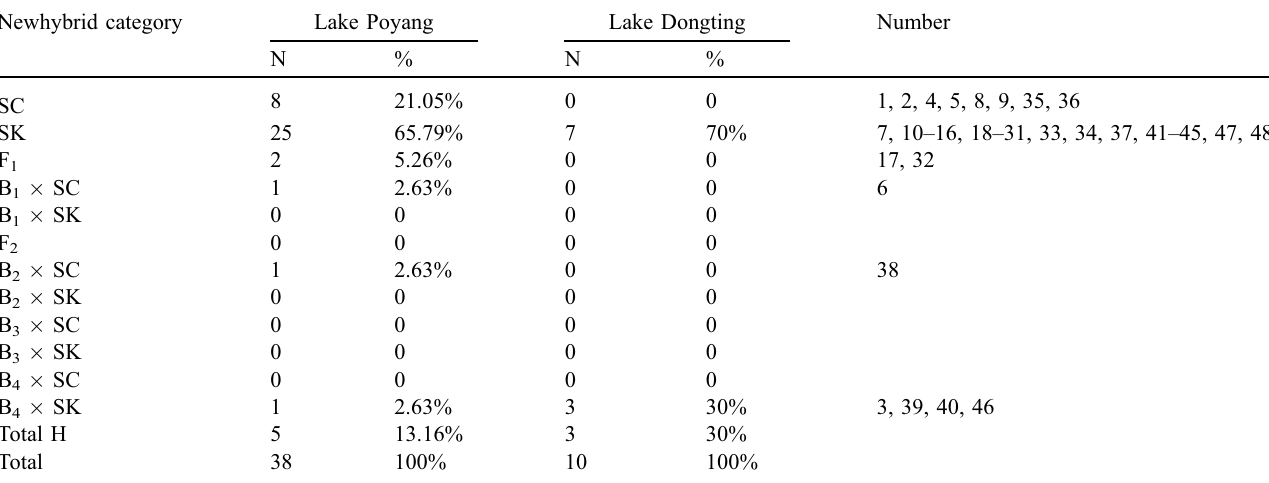
Table 3. Assignment of the intermediate forms using Newhybrids. Newhybrid